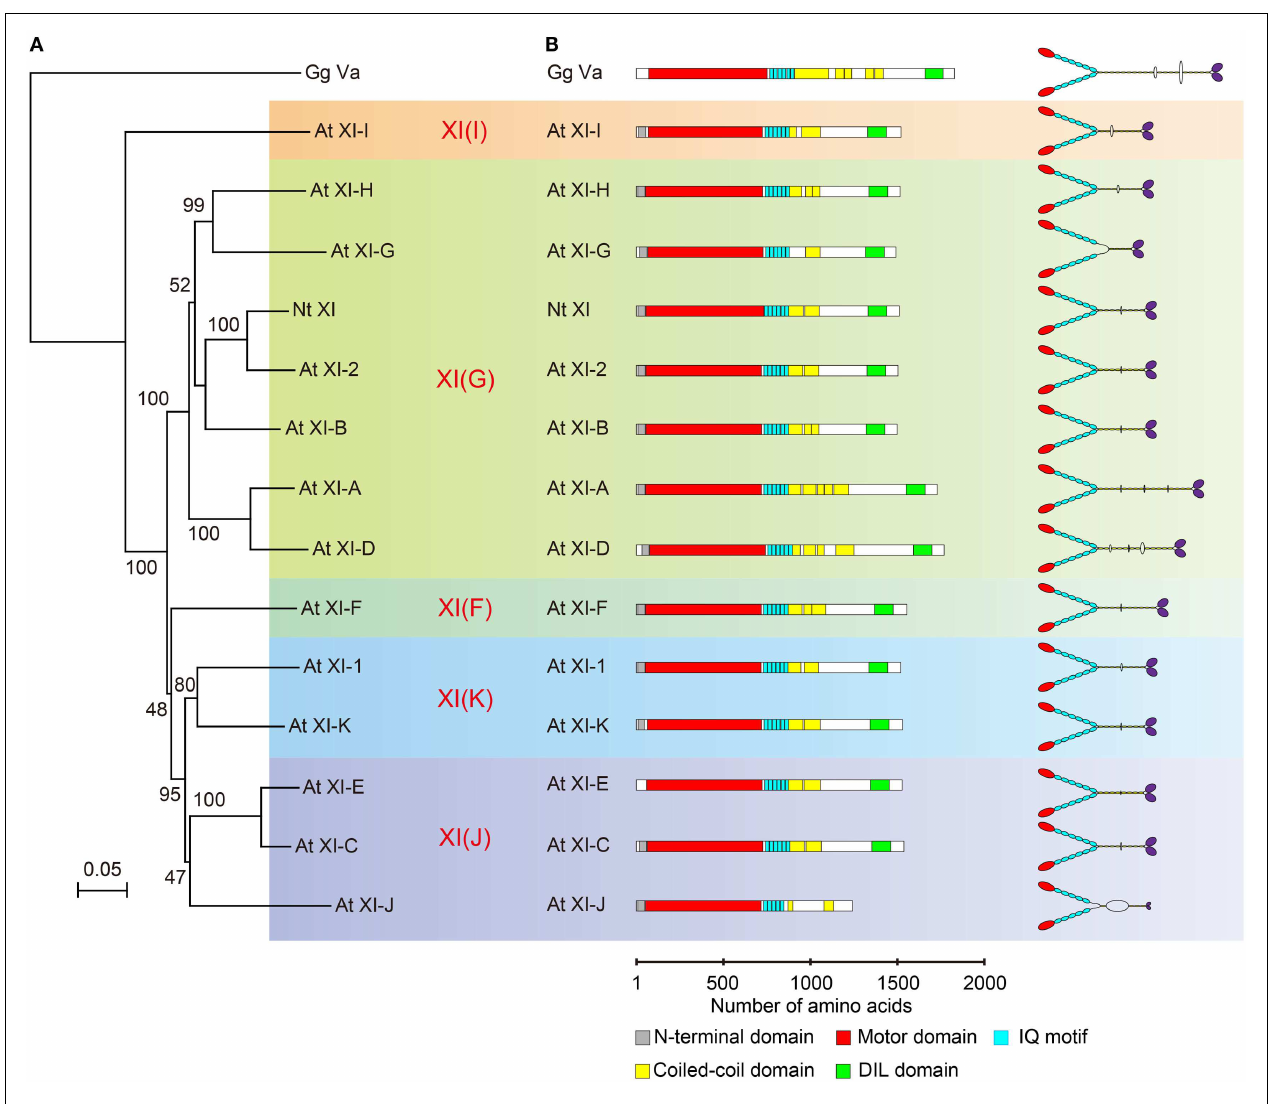
and putative morphology of At myosin XI members. GgVa, Gallus gallus myosinVa; Nt XI, Nicotiana tabacum 175-kDa myosin XI; and At XI, Arabidopsis thaliana myosin XI.